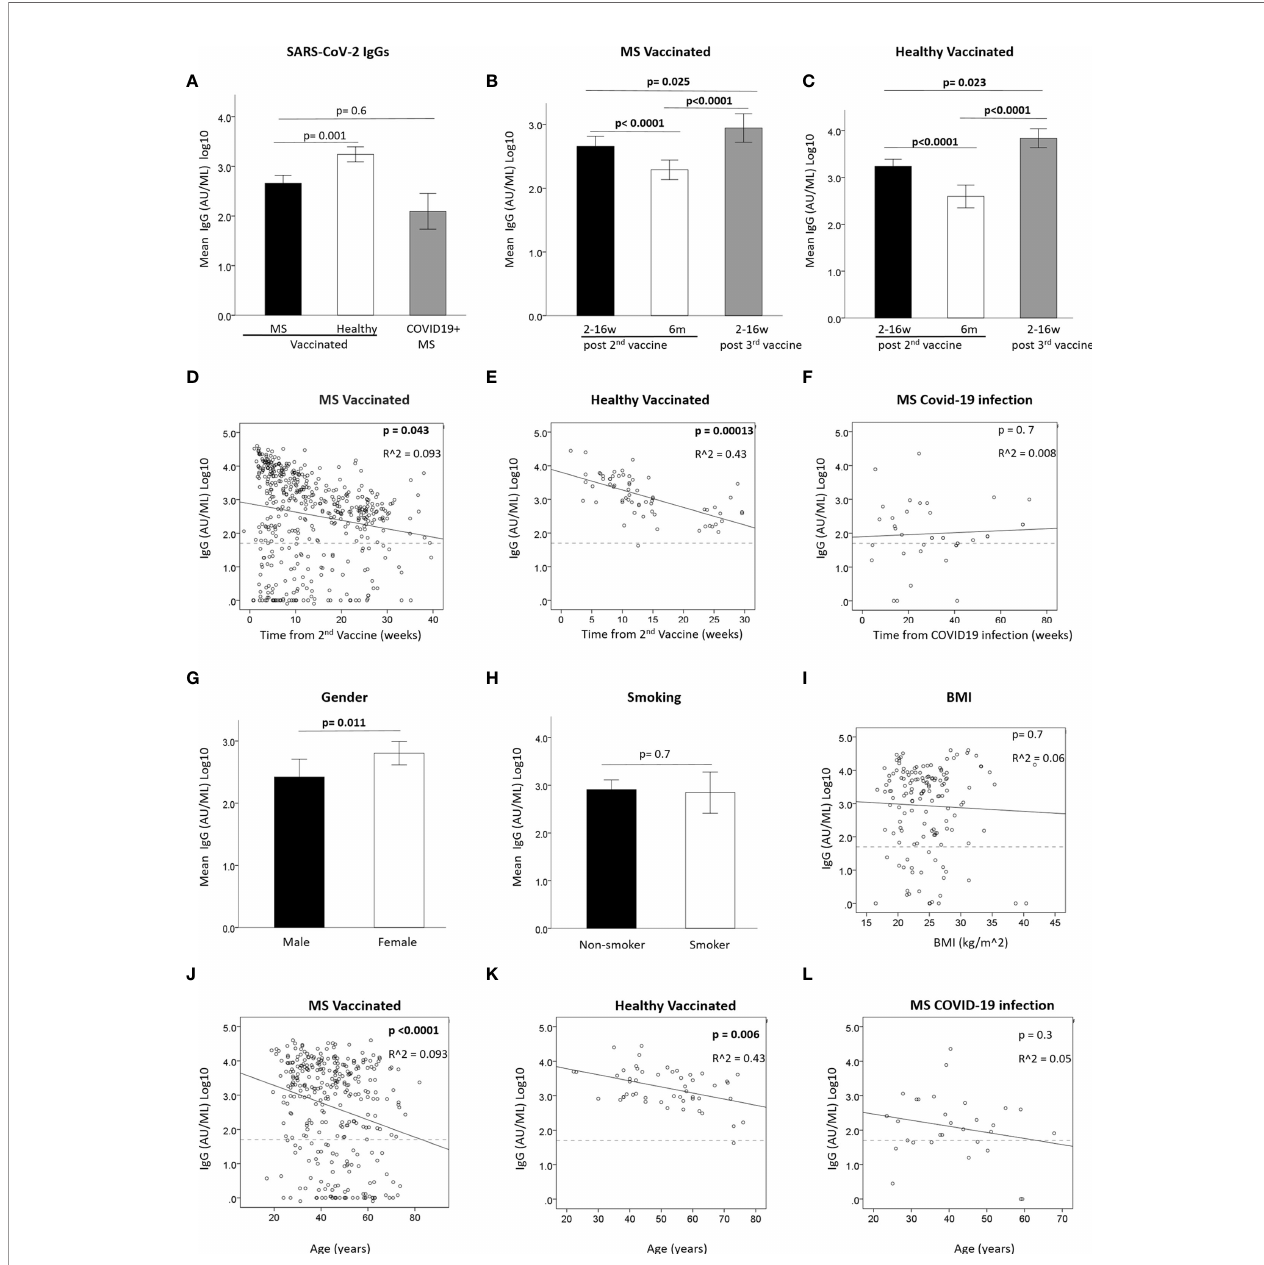
FIGURE 1 | (A) Mean IgG levels after 2 nd vaccine in vaccinated PwMS (N=309) and healthy (N=48) and in unvaccinated COVID-19-recovered PwMS (N=29). (B, C) Mean IgG level in vaccinated PwMS (N=479) (B) or healthy (N=65) (C) at 3 time-points: <3months and 6 months from 2 nd vaccine and <3 months from 3 rd vaccine. (D, E) Correlation between IgG and time since 2 nd vaccine in vaccinated PwMS (N=311) (D) or healthy) (N=46) (E) . (F) Correlation between IgG and time since COVID-19 infection in unvaccinated PwMS. (G) mean IgG difference between male (N=107) and female (N=204) PwMS after 2 nd vaccine. (H) mean IgG difference between non-smokers (N=166) and smokers (N=37) PwMS after 2 nd vaccine. (I) Correlation between IgG post 2 nd vaccine and BMI in PwMS (N=144). (J, K) Correlation between IgG after 2 nd vaccine and age in vaccinated PwMS (N=311) (J) or healthy (N=46) (K) . (L) Correlation between IgG and age in unvaccinated PwMS recovered from COVID-19 (N=38). Dashed horizontal grey line represents minimum seropositive border